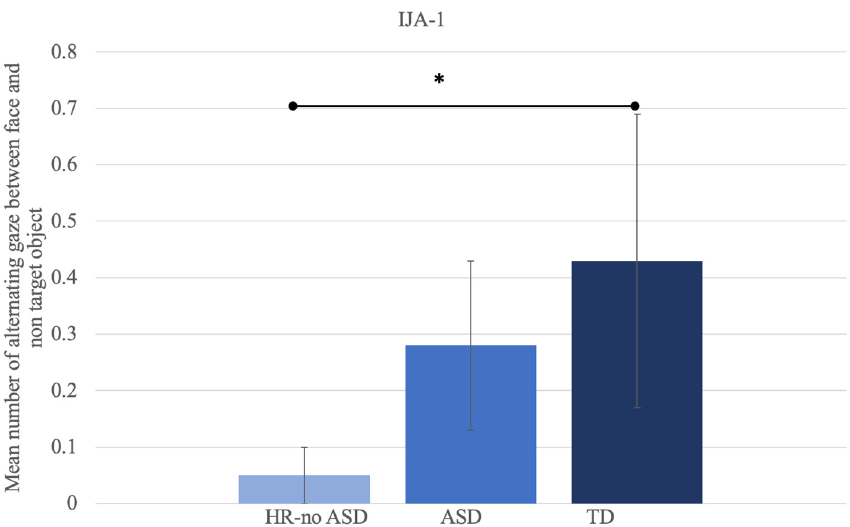
Figure 2. Number of gaze alternations made between the model’s face and non-target object in IJA-1. Error bars represent standard deviations. * p < 0.05.